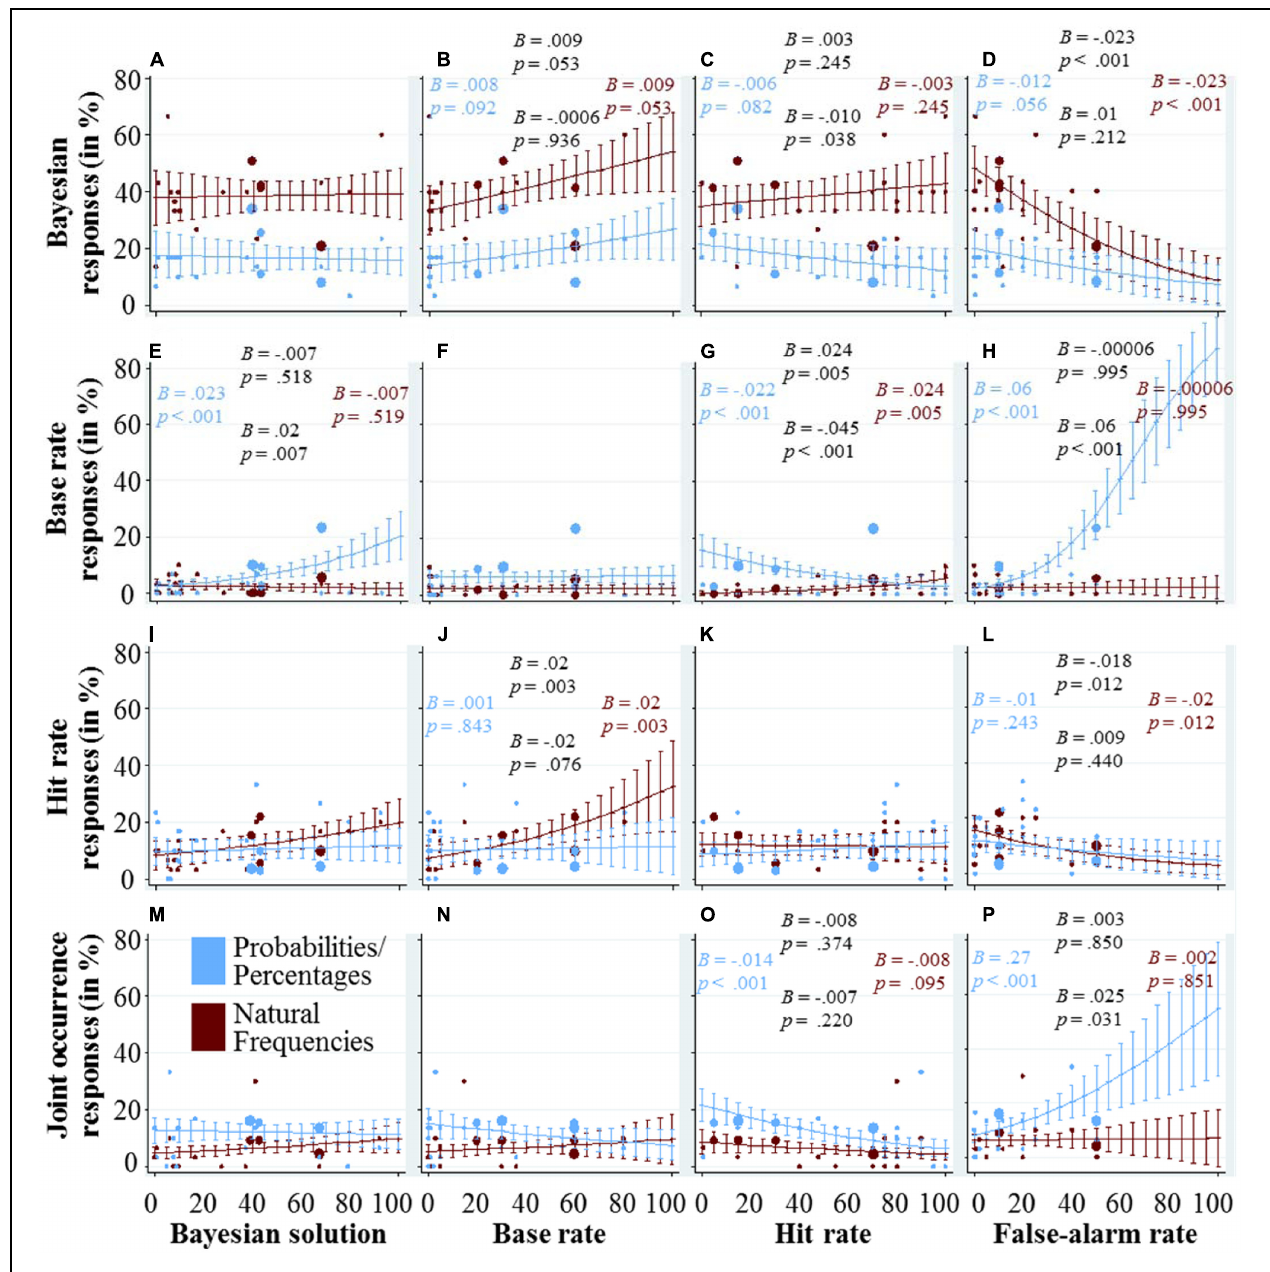
FIGURE 4 | Each of the panels (A–P) visualizes how the quantitative variable that is displayed at the x-axis affects the usage of the cognitive strategy that is displayed at the y-axis. The dots represent the average usage in the different tasks and versions (see caption of Figure 2 for details). The marginal effects and their confidence intervals are based on